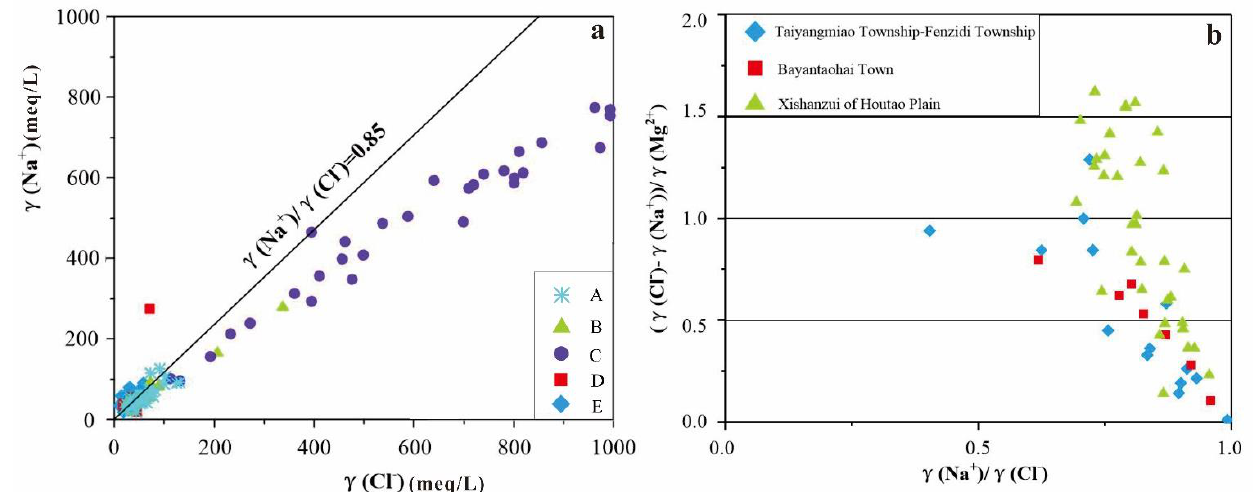
Figure 7. The γ(Na + )/γ(Cl − ) scale coefficient ( a ) and relationship between γ (Na + ) /γ (Cl − ) and ( γ (Cl − )- − )- γ (Na + ))/ γ (Mg 2+ ) diagram ( b ) of shallow groundwater in Hetao γ (Na + ))/ γ (Mg 2+ ) diagram ( b ) of shallow groundwater in Hetao Plain. ( γ (Cl